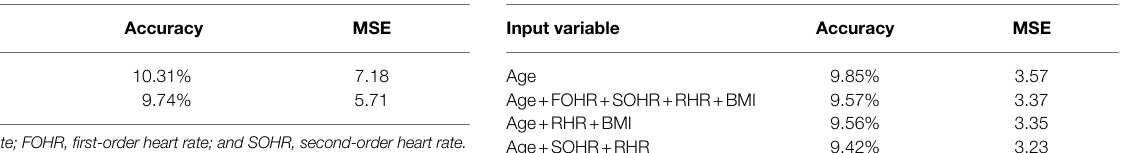
TABLE 3 | Artificial neural network (ANN) to predict HR max .